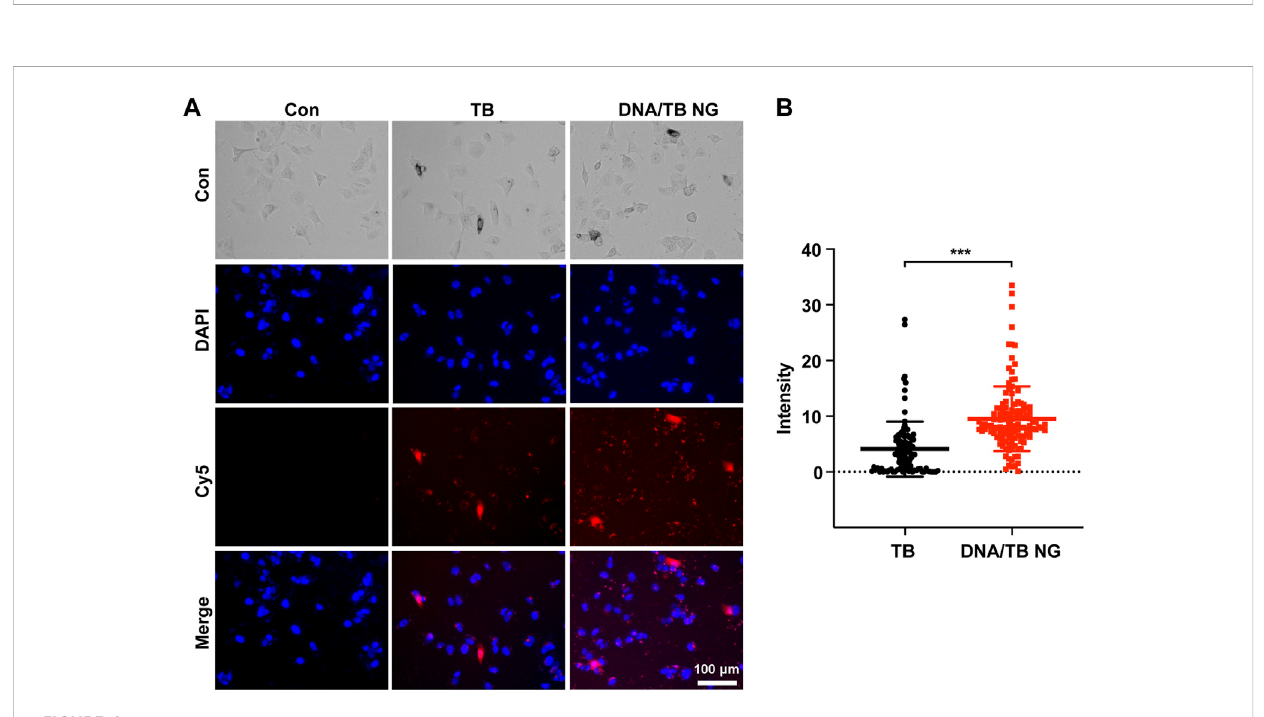
Frontiers in Bioengineering and